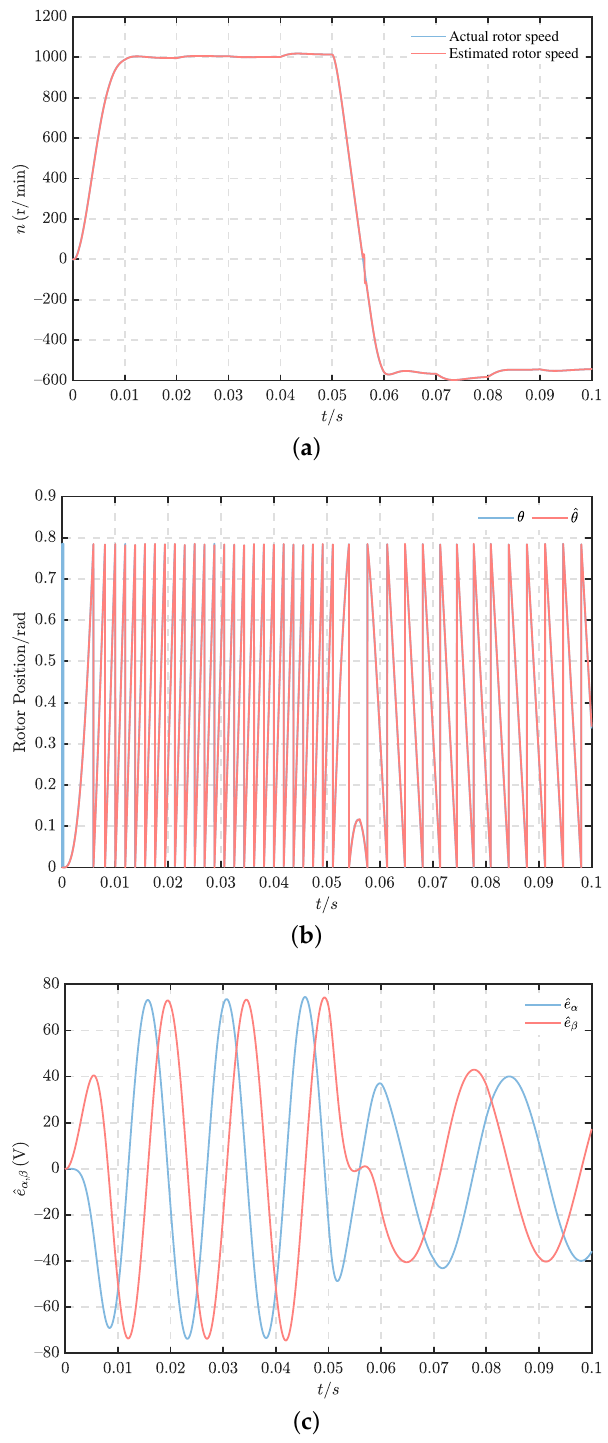
Figure 21. Responses of the simulation with improved SMO combined with feedforward PLL (with propeller load). ( a ) Rotor speed. ( b ) Rotor position. ( c ) Estimation of the